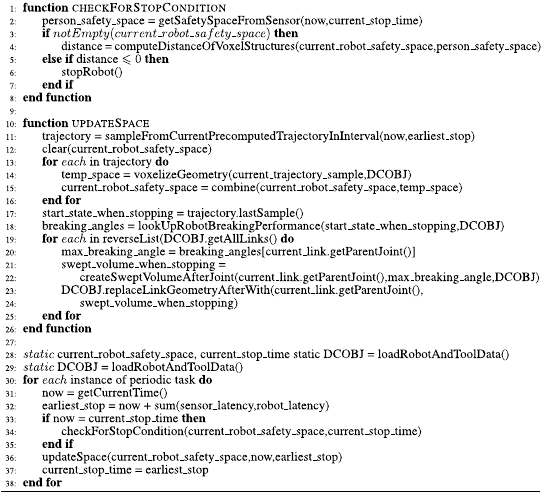
Algorithm 1. Robot Safety Space